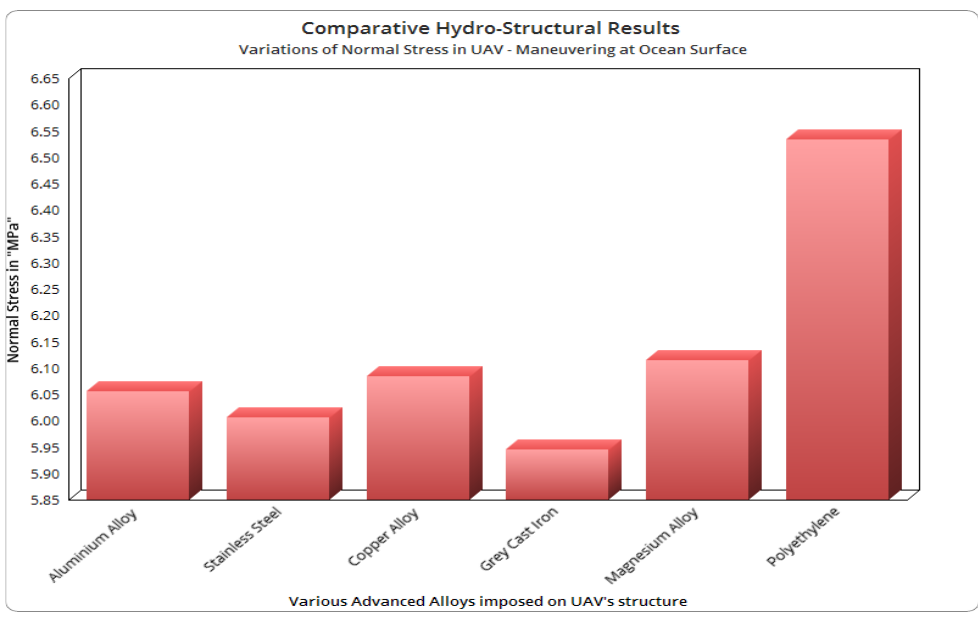
Figure 29. Comparative normal stress variations for various alloys.